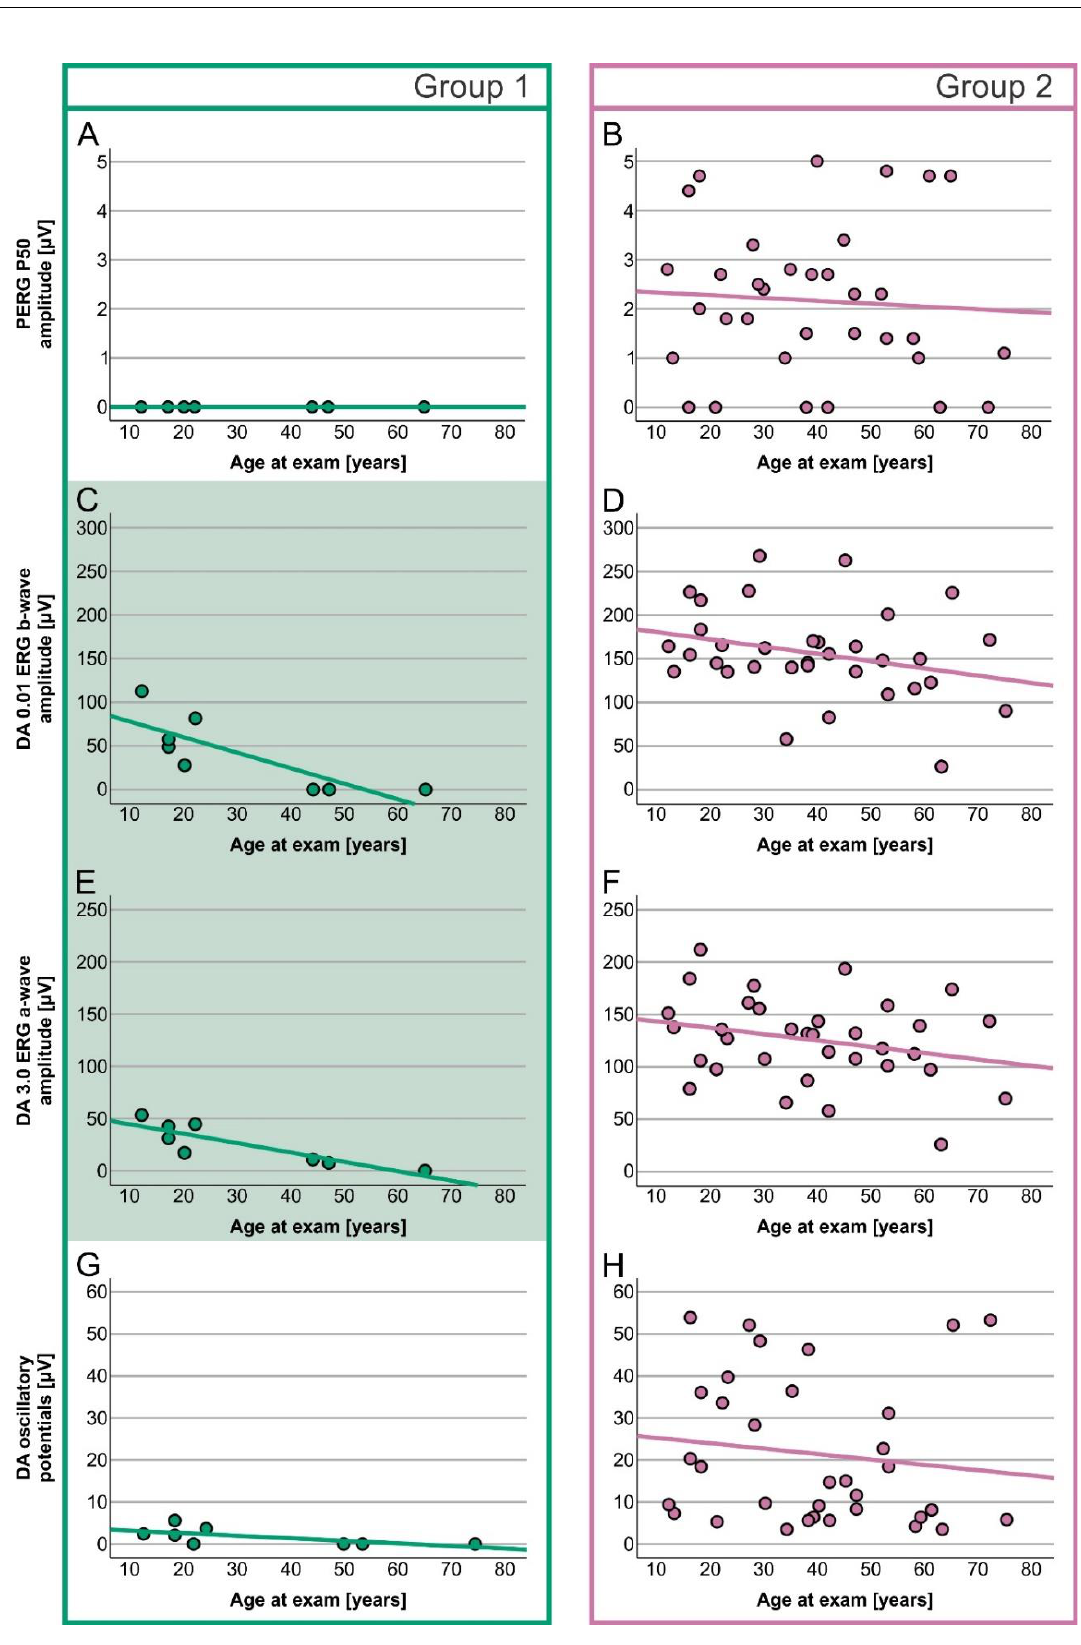
Figure 3. Age-dependent decrease (linear regression) in PERG P50 amplitude and DA ERG responses in Group 1 ( A , C , E , G ) and 2 ( B , D , F , H ) patients. Group 1 is marked with green and Group 2 with purple. Green-colored graphs represent a significant correlation between age and DA 0.01 ERG b − wave and DA 3.0 ERG a − wave amplitudes.